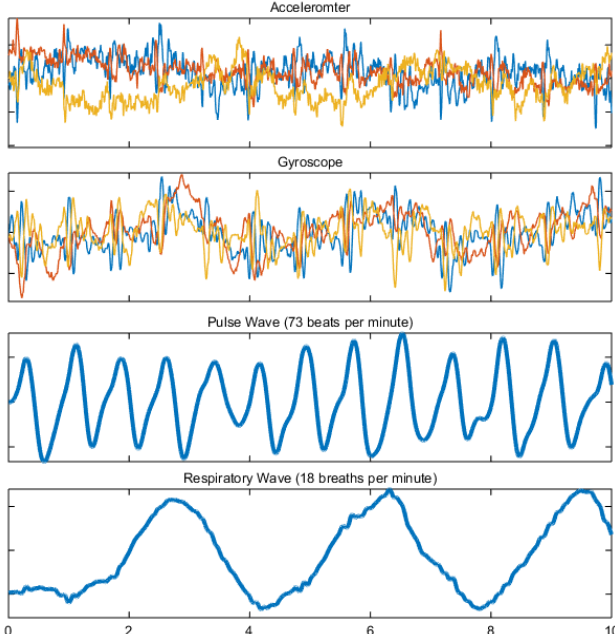
Fig. 2. Example of pulse and respiratory wave estimation from both accelerometer and gyroscope readings of a participant while standing up.